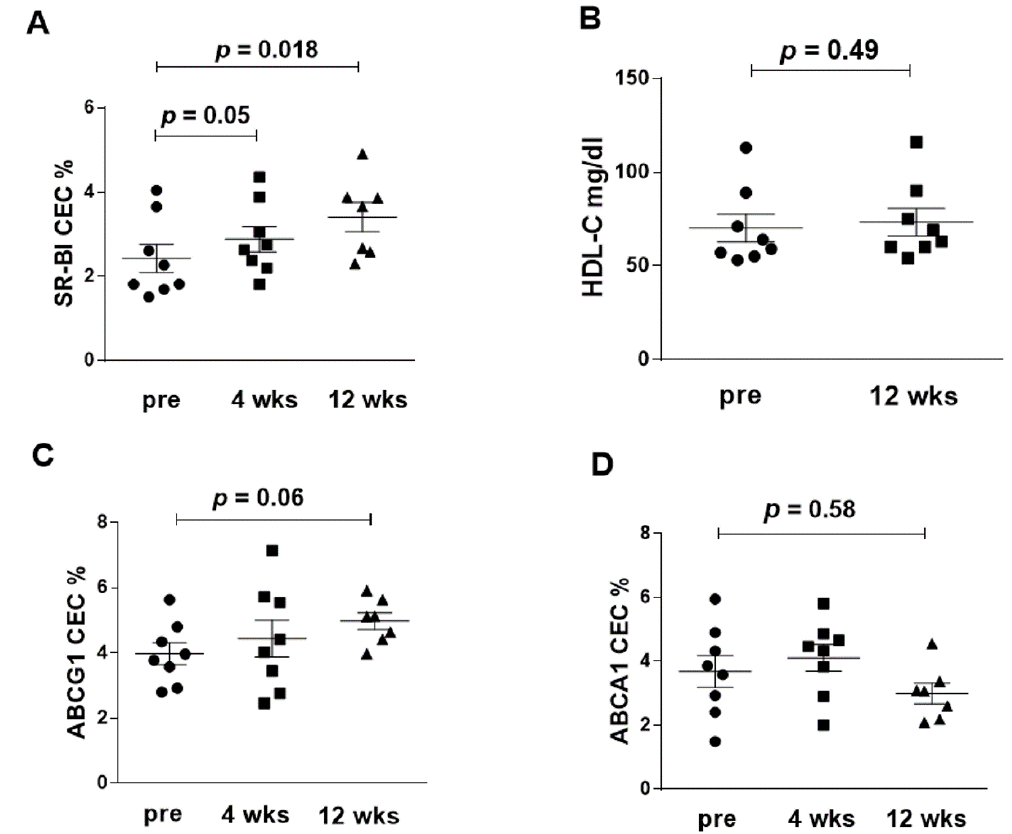
Figure 2. Serum cholesterol e ffl ux capacity (CEC) before and after tocilizumab treatment. ( A ): CEC, expressed as percent e ffl uxed of total cell cholesterol, specifically mediated by the SR-BI transporter. ( B ): HDL-C serum levels (mg / dL) at baseline and after 12 weeks of treatment. ( C ): CEC, expressed as percent e ffl uxed of total cell cholesterol, specifically mediated by the ABCG1 transporter ( D ): CEC, expressed as percent e ffl uxed of total cell cholesterol, specifically mediated by the ABCA1 transporter. Statistical significance was calculated with Wilcoxon test for paired samples with skewed distribution.